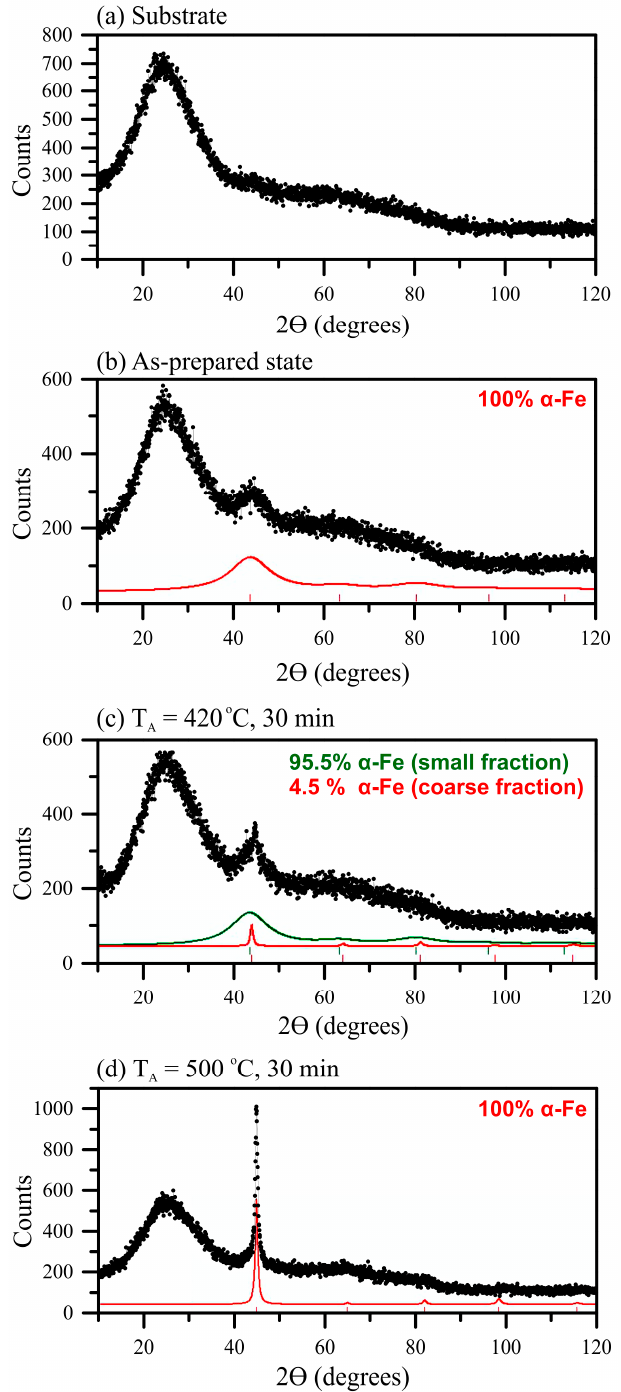
Figure 2. XRD data of the glass substrate ( a ) and Fe 73.5 Nb 3 Cu 1 Si 13.5 B 9 film with the thickness of 200 nm in the as-prepared state ( b ) and after the heat treatment at the temperatures of 420 ◦ C ( c ) and 500 ◦ C ( d ) for 30